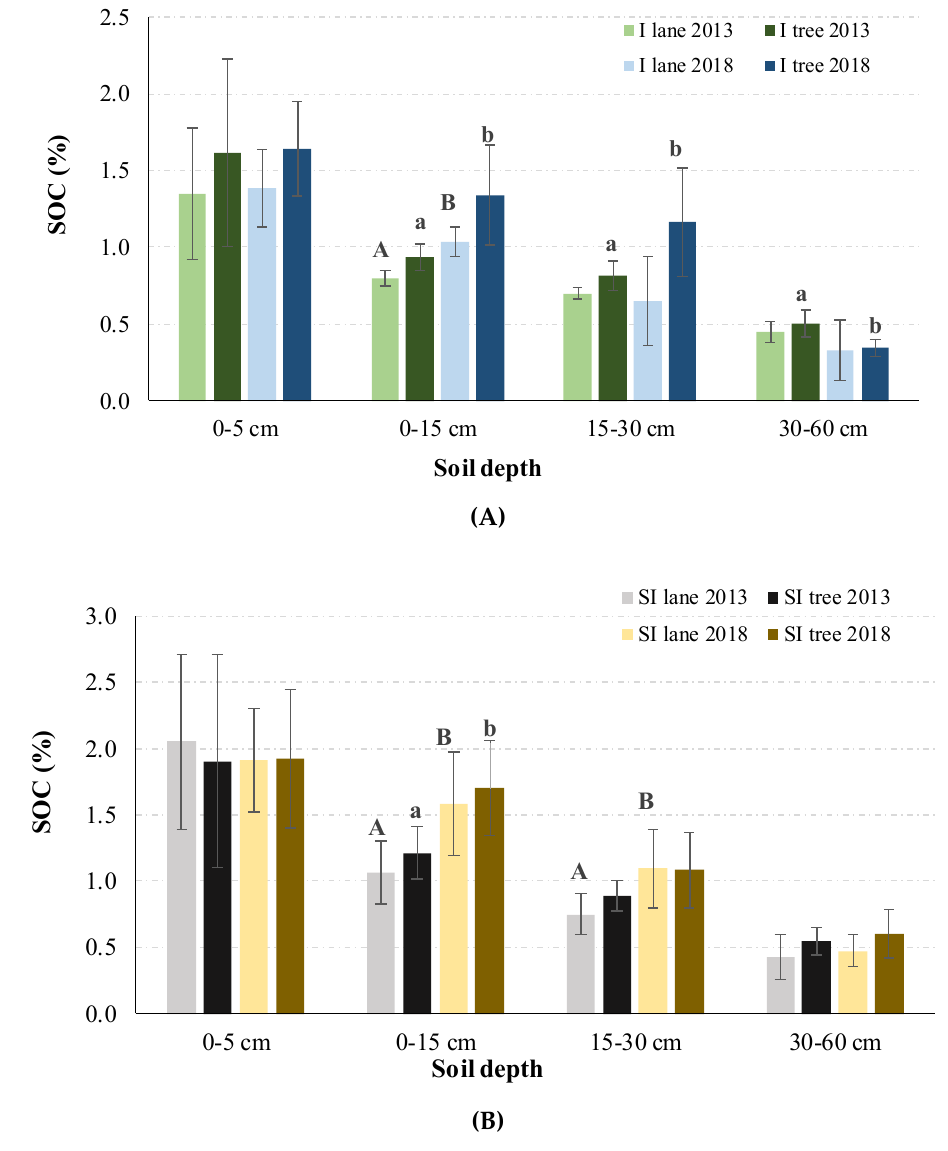
Figure 5. Comparison of soil organic carbon concentration (SOC; %) evolution between 2013 and 2018 in the intensive ( A ) and superintensive ( B ) olive orchard. Different letters indicate statistically significant differences ( p < 0.05, using a Kruskal–Wallis test) between the two soil sampling dates for the same soil depth (0–5, 0–15, 15–30 and 30–60 cm) and location (lane, capital letters, or tree, lowercase letters) within each orchard. Error bars are standard deviation, n = 8.